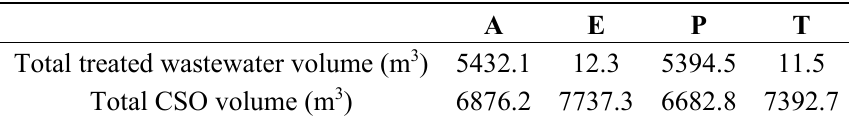
Table 2. Total treated wastewater and